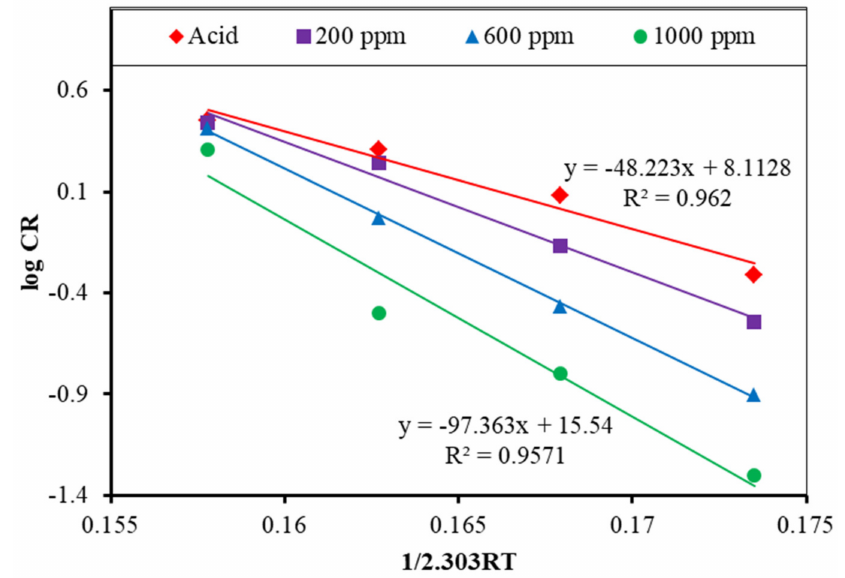
Figure 12. Arrhenius plot for the MS in the 1 M H 2 SO 4 , both with and without an